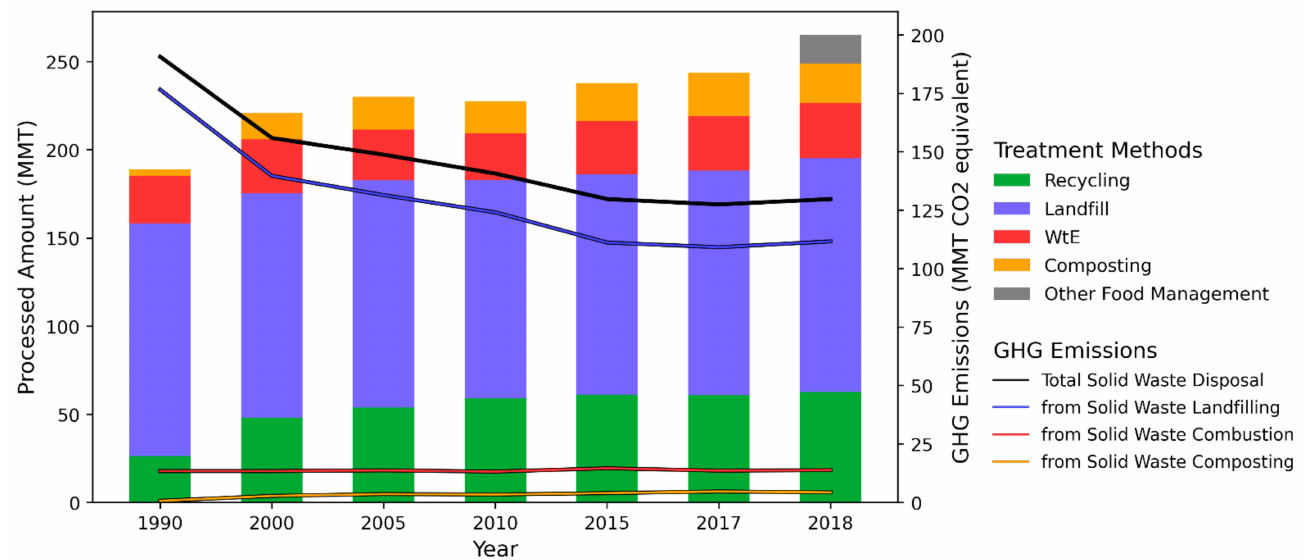
Figure 6. Changes in U.S. generation and disposition of MSW, and associated GHG emissions, from 1990 to